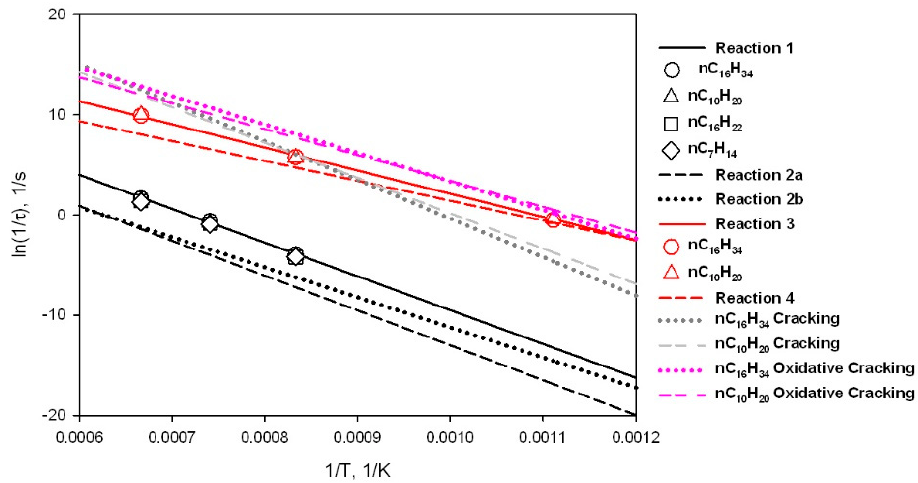
Figure 10. Comparison of the rate of different reactions.